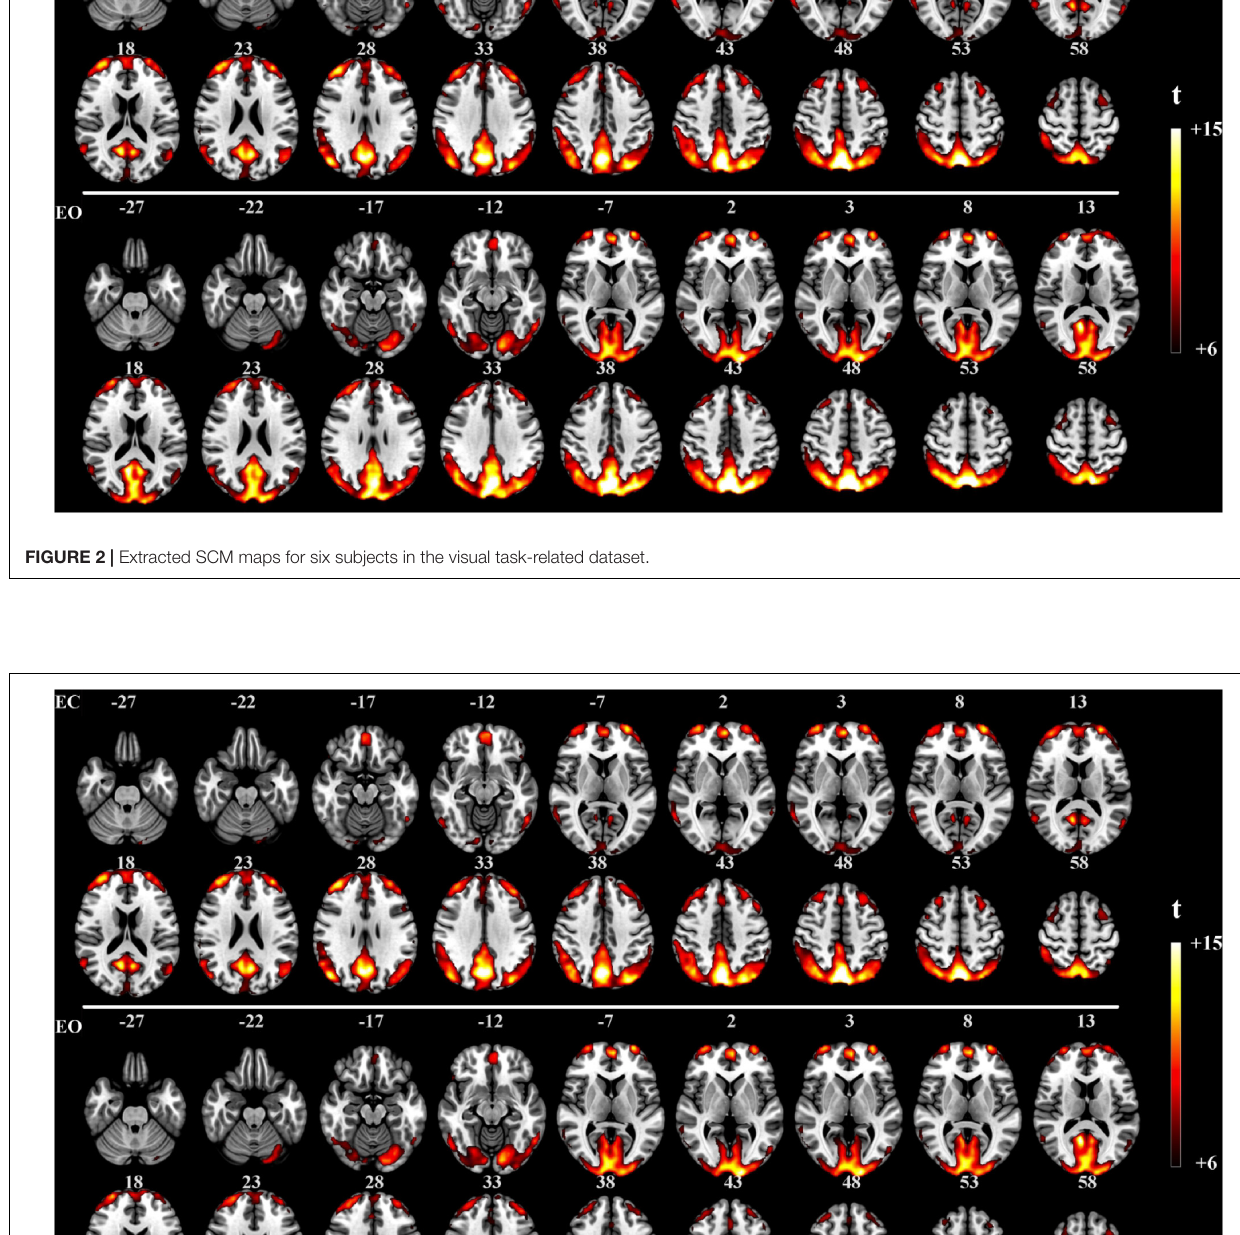
Frontiers in Human Neuroscience |